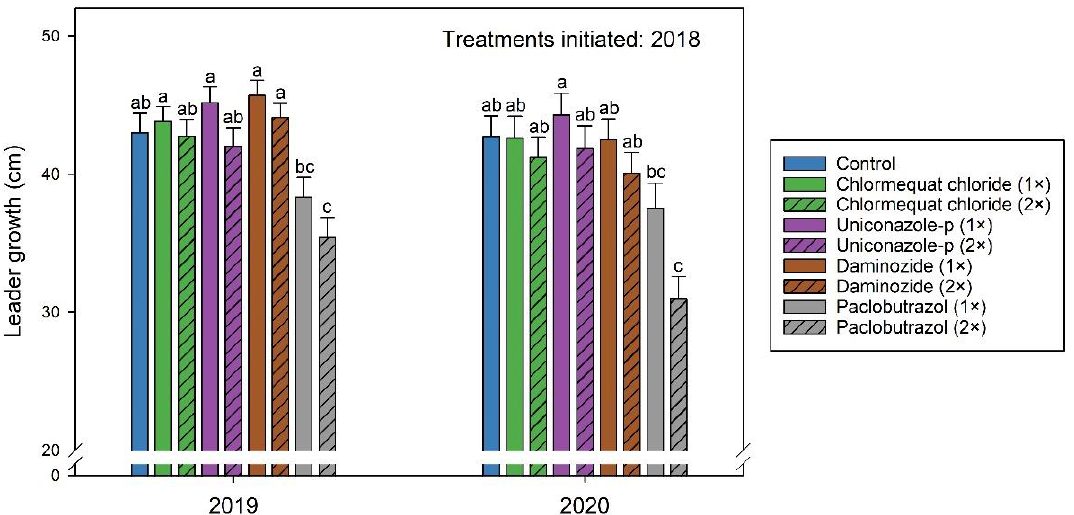
Figure 5. Mean annual leader growth of Fraser fir trees treated with four plant growth regulators or left untreated (Control). Each PGR was applied once (1 × ) or applied a second time approximately 1 week later (2 × ). Foliar treatments were applied annually in 2018 and 2019. Means within a year indicated by the same letter are not different at p < 0.05. Mean separation by Tukey’s HSD test.